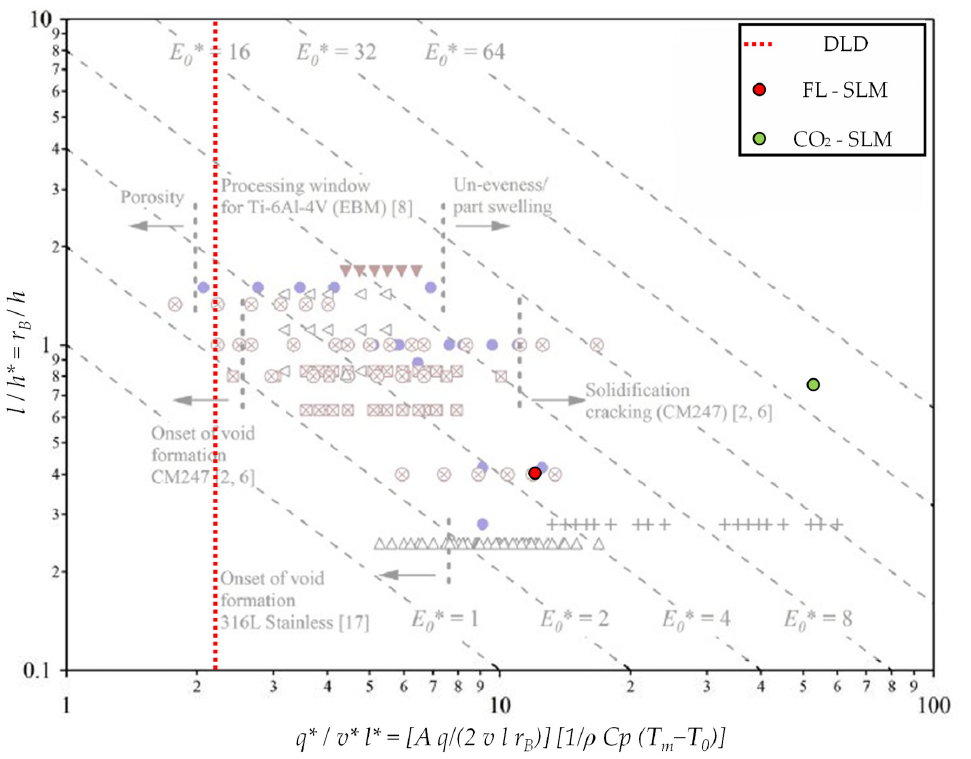
Figure 3. Processing diagram of several AM alloys with the materials studied in this work, based on [25]. The x axis is the E* min